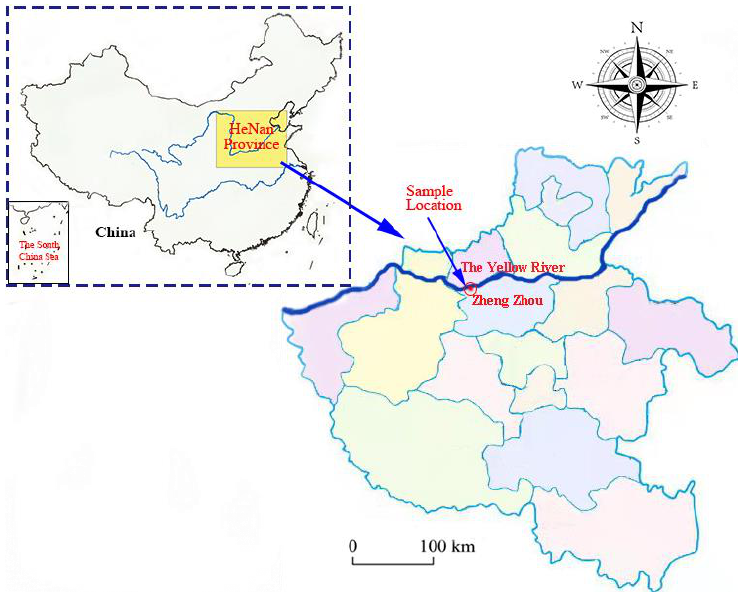
Figure 1. Silt sample location.